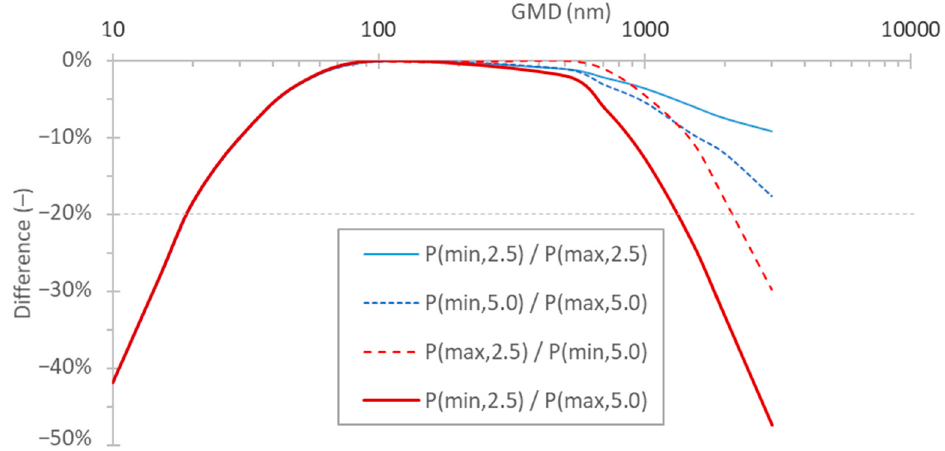
Figure 5. Differences between various setups with max penetration (“max”) and min penetration (“min”) setups and cyclonic separators of 2.5 μ m and 5.0 μ m.